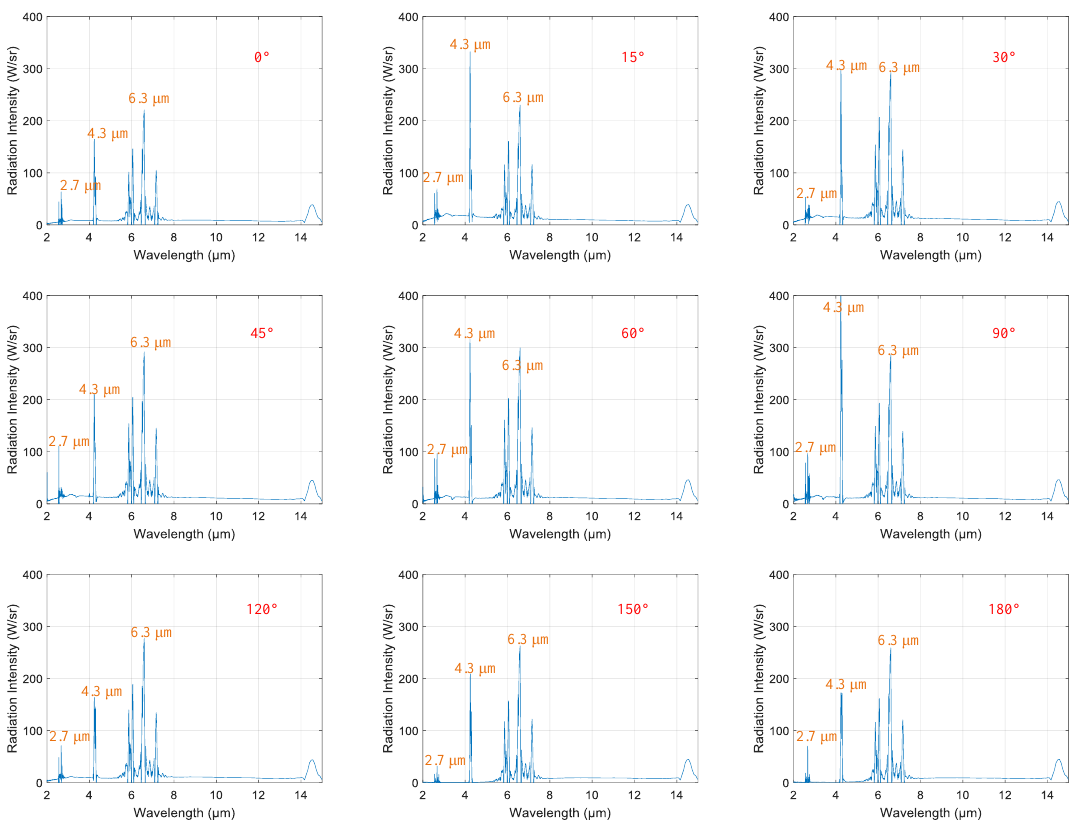
Figure 12. Spectral radiation intensity of the UAV at different observation angles.